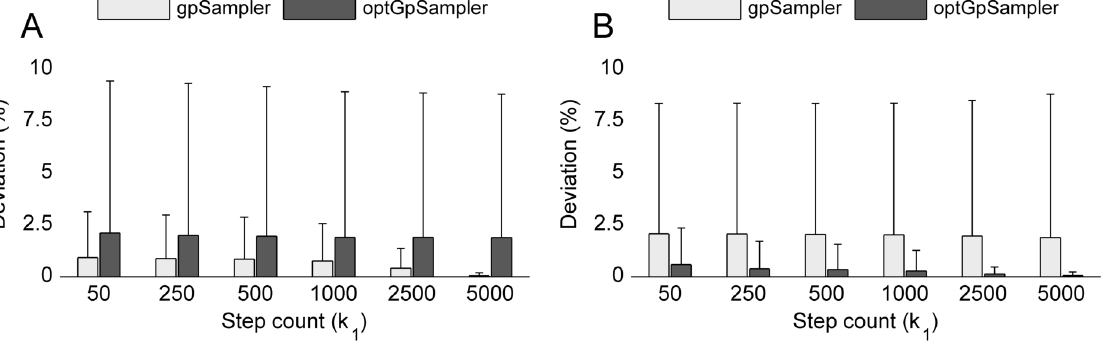
Figure 6. xy -deviation for E. coli iAF1260 xy -deviation from samples obtained with sampler x at step count k 1 to sampler y using k 2 =5000. (a) Deviation to samples obtained by y = gpSampler . (b) Deviation from samples obtained by y = optGpSampler . Self-deviation ( x ~ y ) is small for both samplers, but there is a large cross-deviation ( x = y ). For this large network, the we do not observe convergence of gpSampler to the samples obtained by optGpSampler or vice versa as in Fig. 4.